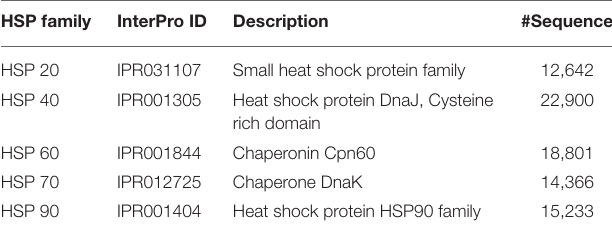
TABLE 2 | Number of HSP sequences collected from InterPro, corresponding to different HSP